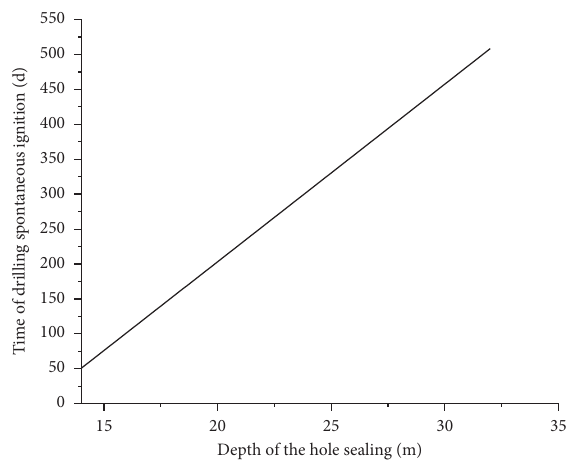
Figure 8: Influence of sealing depth on natural ignition time of